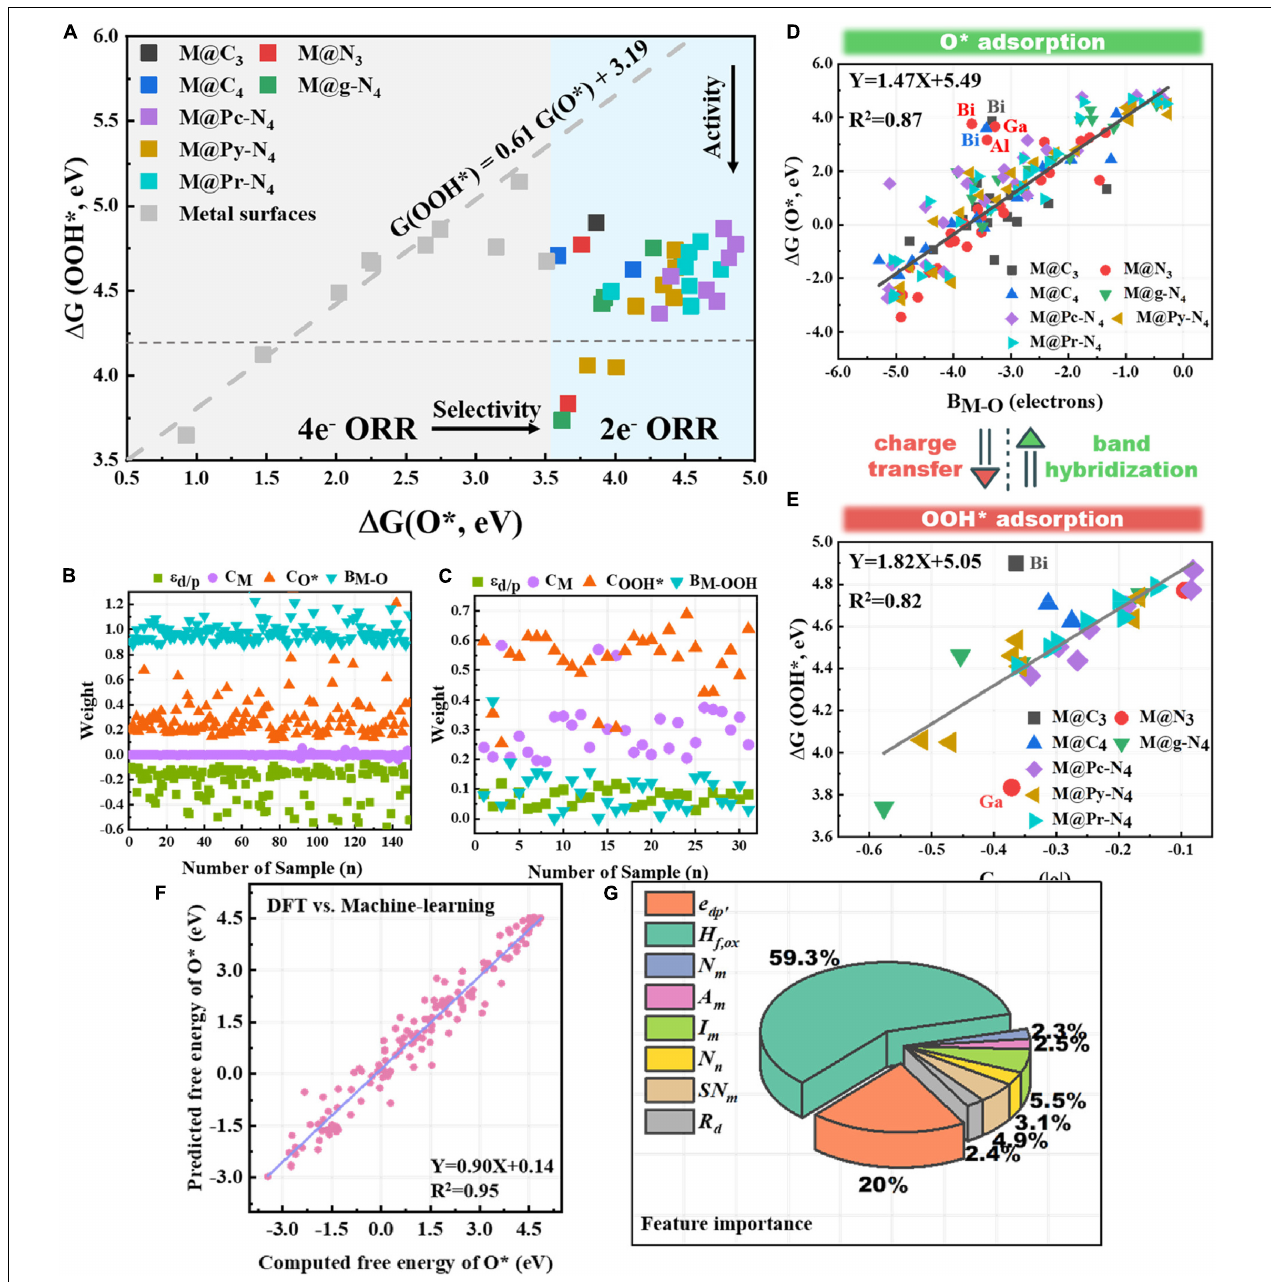
FIGURE 6 | (A) Variations of (cid:49) G(O*) and (cid:49) G(OOH*) on the 31 studied SACs. (B) and OOH* (C) adsorption. (D) The proportional relationships between the (cid:49) G(O*) and BM-O. (E) The proportional relationships between the (cid:49) G(OOH*) and COOH*. (F) Comparison between DFT and predicted (cid:49) G(O*) values. (G) Random forest model‘s feature importance for (cid:49) G(O*). Reproduced from Guo et al. (2019) with permission from Copyright (2019) American Chemical